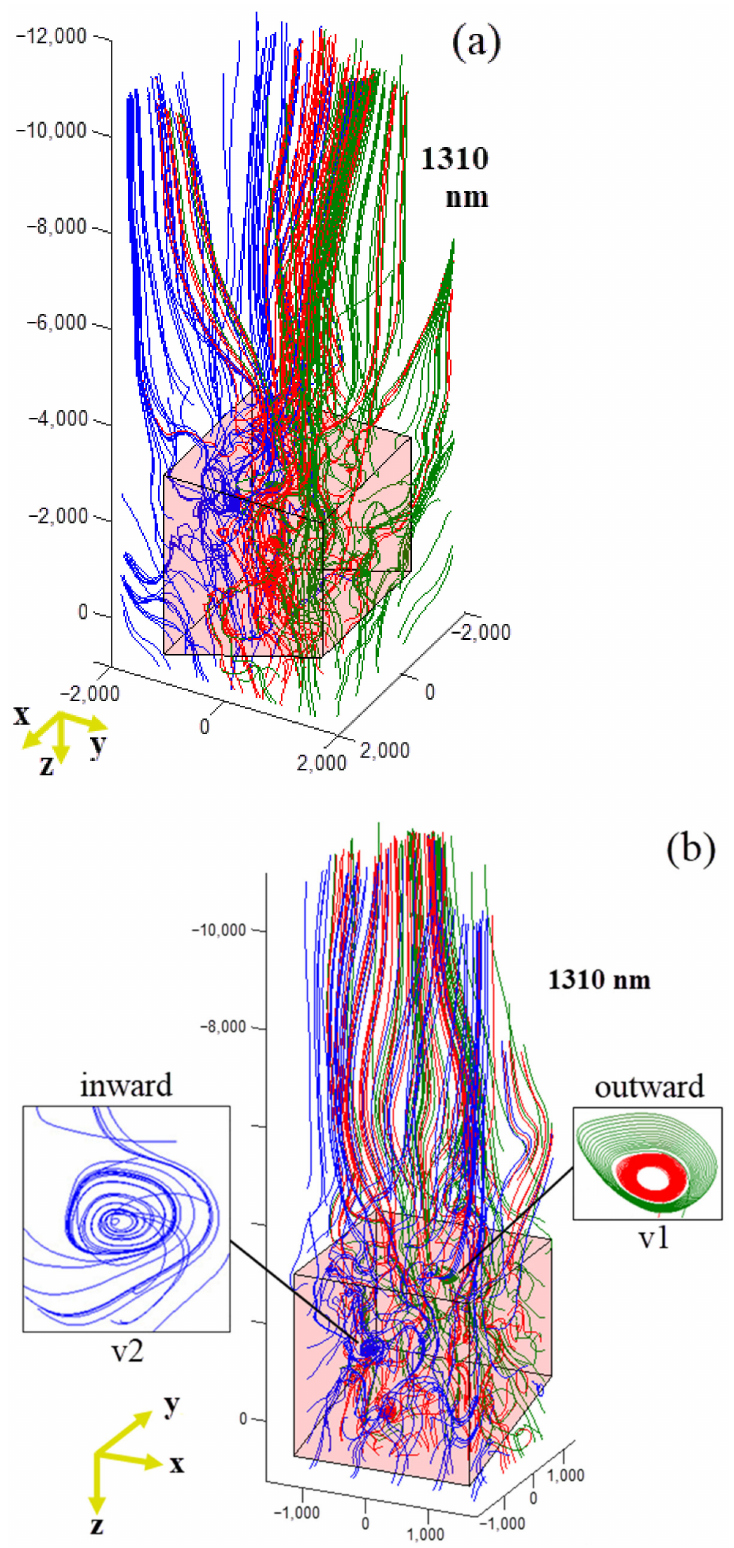
Figure 3. Overview ( a ) and the rotated view ( b ) of 3D Poynting vector distribution for the model of 1310 nm irradiation with the colour codes of streamlines: blue lines for long-base section ( − y direction), red lines for middle section (around 0 position on y axis), and green lines for short-base section (+ y direction). Insets in ( b ): Outward vortex v1 and Inward vortex